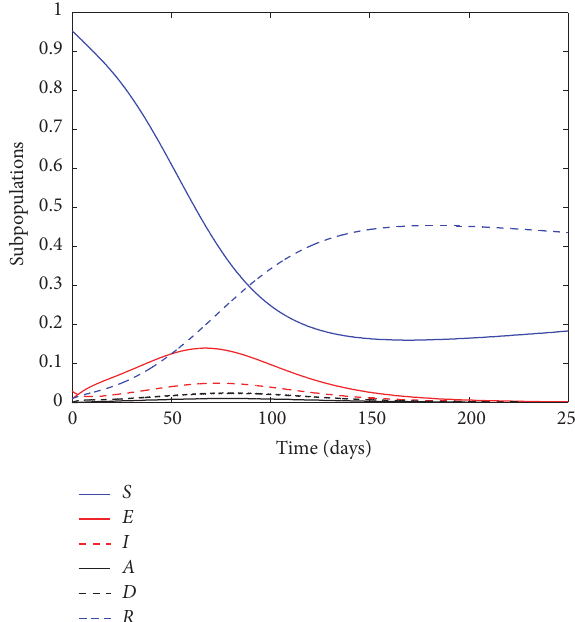
Figure 1: Natural evolution of the subpopulations.